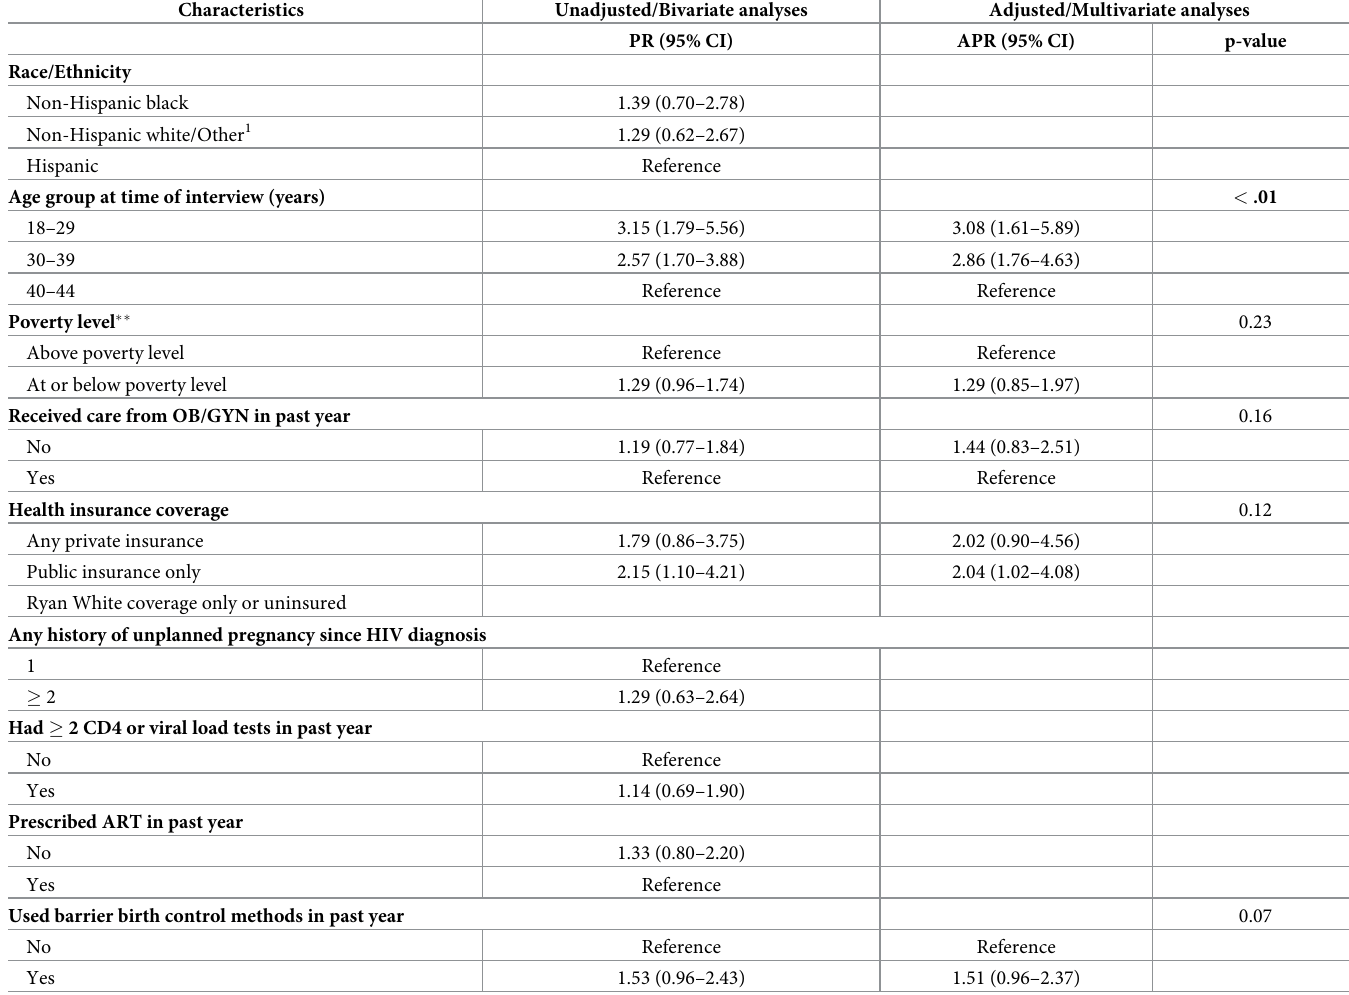
Table 3. Associations between selected characteristics and using highly effective, non-daily/weekly adherence contraception (LARC and DMPA) among HIV-posi- tive women in care—Medical Monitoring Project, 2013–2014 (N =